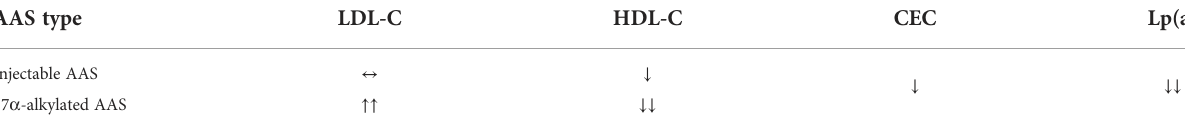
TABLE 1 Effects of injectable and 17 a -alkylated AAS on serum lipoproteins and cholesterol ef fl ux capacity. AAS